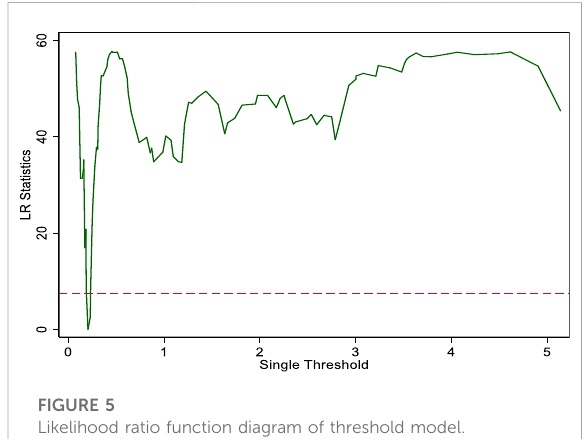
FIGURE 5 Likelihood ratio function diagram of threshold model.